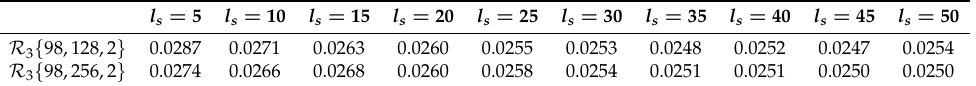
Figure 3. Best (orange) and final (blue) MSE values for different values of sequence length l s , evaluated on two distinct RNN architectures. ( a ) R 3 { 98,128,2 } . ( b ) R 3 { 98,256,2 } . Table 3. Obtained best MSE values for different values of sequence length l s .